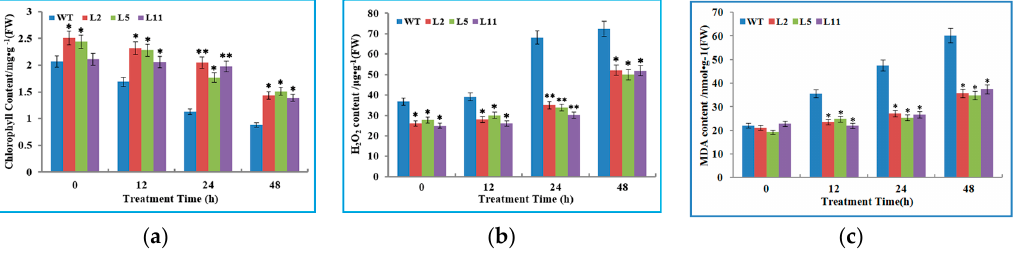
Figure 5. Accumulation of ( a ) chlorophyll, ( b ) H 2 O 2 and ( c ) malondialdehyde (MDA) in the WT and transgenic lines (L2, L5 and L11) under cold stress conditions (2 °C) at different time points. Data are the mean ± SE of three biological replicates, while asterisks indicate significant differences (* p < 0.05, ** p < 0.01) in comparison with the wild type. Genes 2017 , 8 , 179